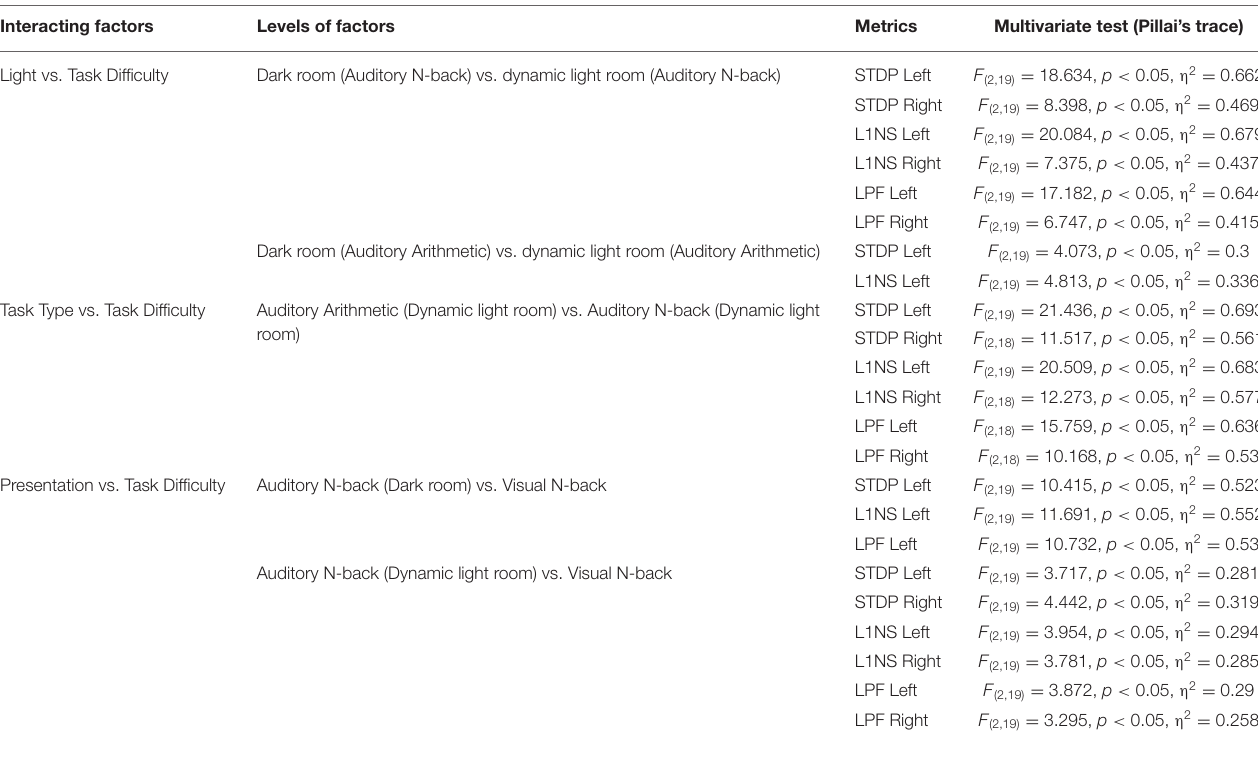
TABLE 8 | Multivariate